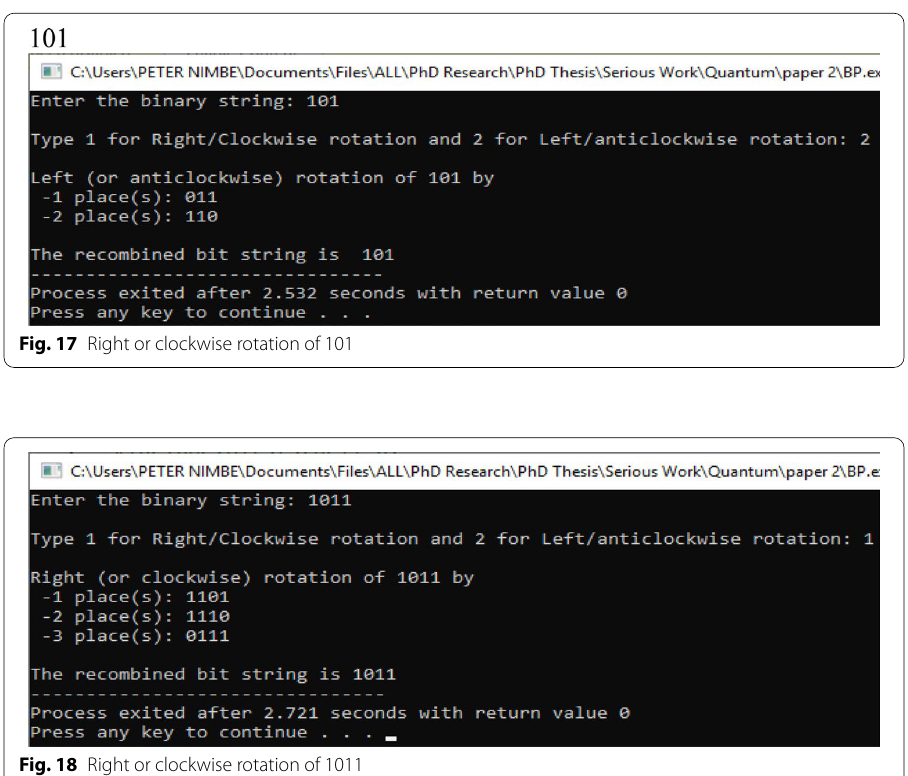
Right (or clockwise) rotation